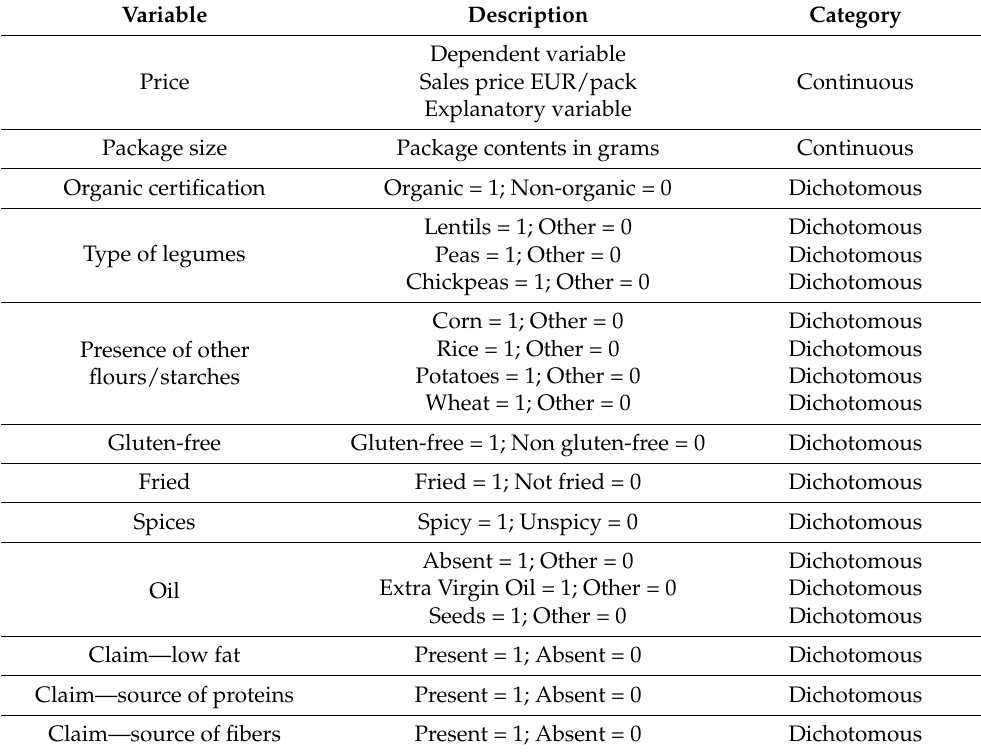
Table 1. Description of variables used in our hedonic price model